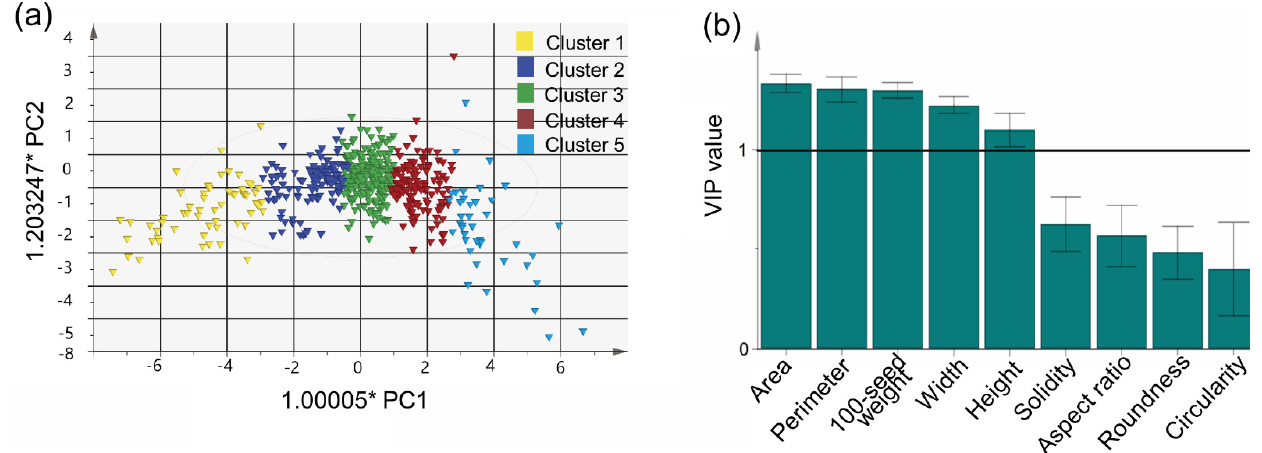
Figure 4. Distribution of 9 seed morphological traits and 589 germplasms of soybean. ( a ) OPLS-DA applying 5 clusters obtained by applying k-means clustering, and ( b ) variable importance in the projection (VIP) value.